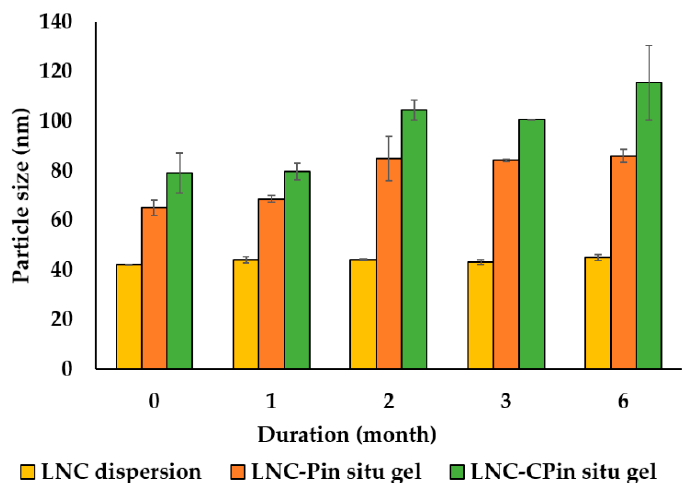
Figure 4. Particle size (nm) of CsA loaded LNC dispersion and in situ gels during storage at 4 °C over time. (n = 3). over time. (n =